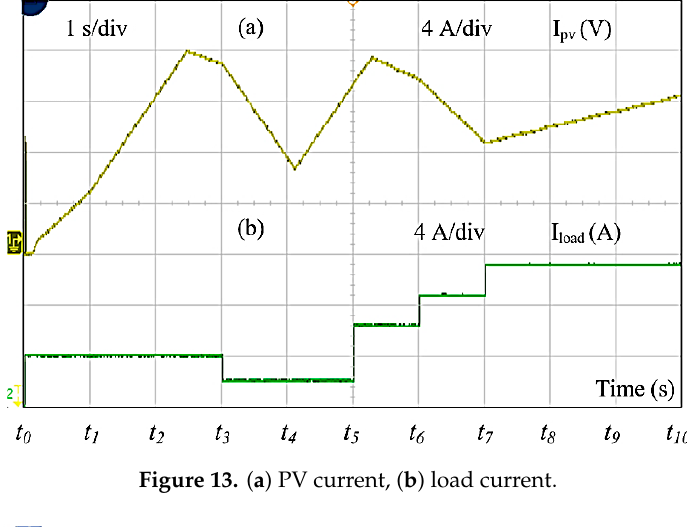
Figure 12. Analysis between the boost converter and IBC results.